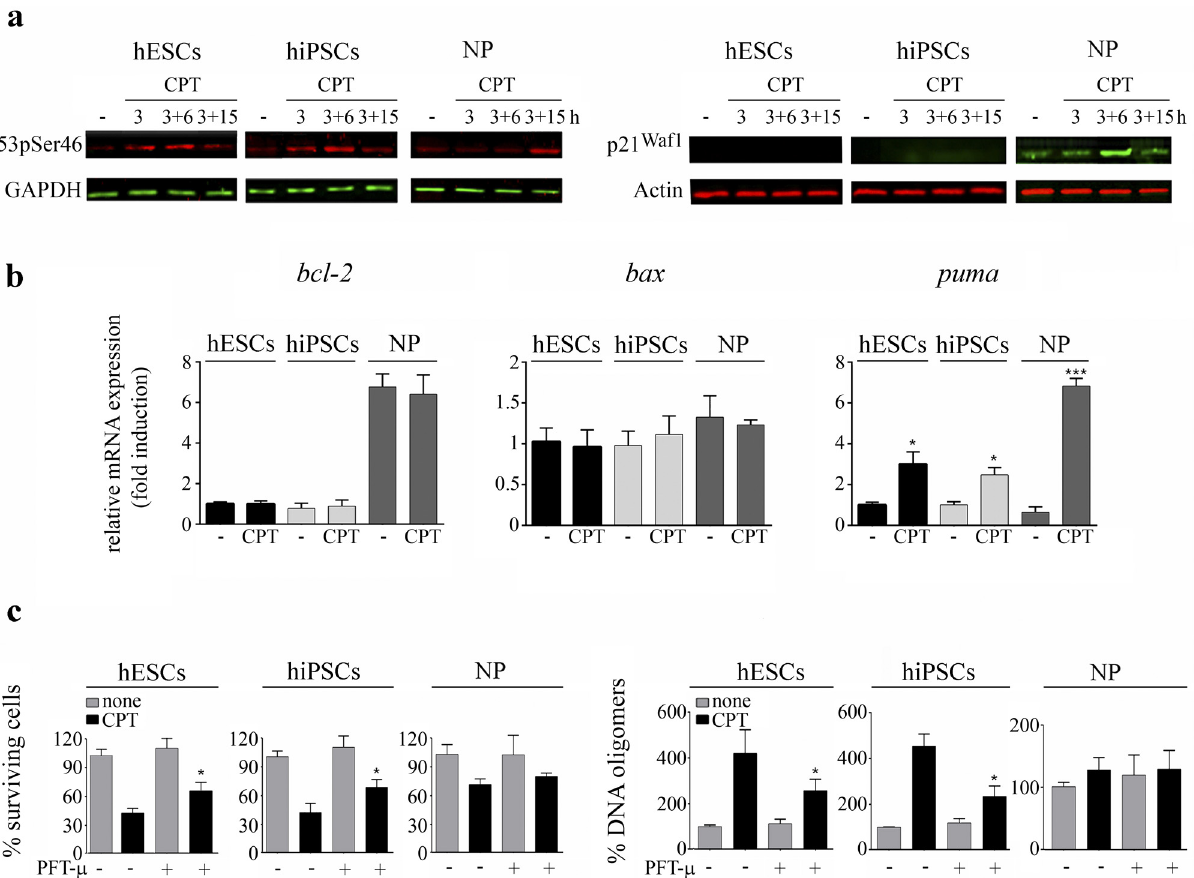
Fig 3. CPT triggers p53 phosphorylation at Serine 46. (a) Time course of p53 phosphorylation at serine 46 upon CPT treatment was analyzed by Western blotting using anti-phospho p53 Ser46 (p53pSer46) specific antibody, immediately after (3h), 6h or 15 h post drug removal (3+6 h, 3+15 h, respectively). GAPDH was used as loading control (left panel). p21 Waf1 expression levels upon CPT exposure in hiPSCs and hESCs-derived NP were analyzed by Western blotting immediately after 1 μ M CPT treatment (3h), 6h or 15h post genotoxic removal (3+6 h, 3+15 h, respectively) using specific antibodies against p21 Waf1 and Actin (right panel) (b) mRNA levels of bcl-2 , bax and puma were analyzed by Real Time RT-PCR in CPT treated or untreated hESCs, hiPSCs and NP. GAPDH expression was used as normalizer. Graph shows mRNA fold induction relative to undamaged hESCs arbitrarily set as 1. Each bar represents the mean ± SEM of three independent experiments. In all cases, a paired Student's t test was used to compare CPT-treated samples to untreated ones (c) Cell viability was measured by the XTT/PMS assay at 6 h after drug removal in PFT- μ treated or untreated cells (10 μ M, 1 h before and during CPT exposure). Results are presented as the percentage of the viability of untreated cells (left panel). PFT- μ treated or untreated cells were harvested 3h after CPT treatment (1 μ M over a 3 h period), and DNA oligomers were measured by immunoassay. Results are presented as the percentage of DNA oligomers of untreated cells. Each bar represents the mean ± SEM of three independent experiments performed in triplicate (right panel) In all cases, a paired Student's t test was used to compare CPT plus PFT- μ treated samples to CPT treated ones. * P < 0.05, *** P <